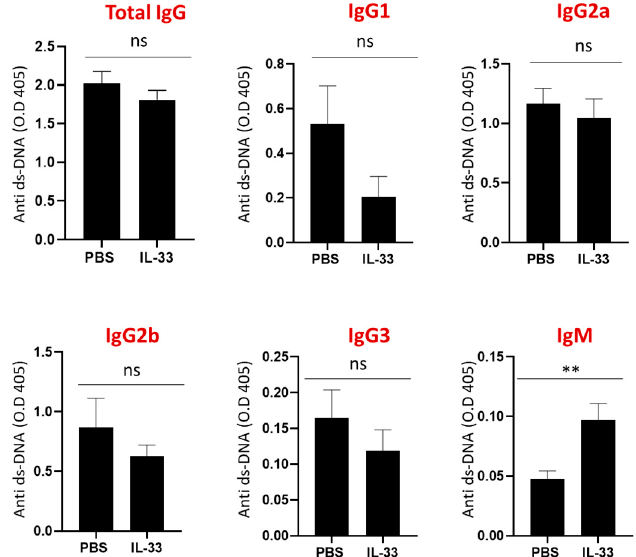
Figure 3. Increased serum IgM anti-dsDNA in NZB / W F1 mice treated with IL-33. Beginning at 6 weeks of age, NZB / W F1 mice were given peritoneal treatments of IL-33 or PBS for five weeks. At the age of 24 weeks, serum samples were collected for the measurement of anti-dsDNA antibodies by ELISA. No significant changes in the concentration of total IgG, IgG subclasses, or IgE anti-dsDNA levels were detected. Significant increase of IgM anti-dsDNA level by IL-33 was detected. Values represent the mean ± SEM. Ns, not significant; ** p < 0.01, analyzed by Student’s t-test. n = 7, Result represents at least two independent experiments.